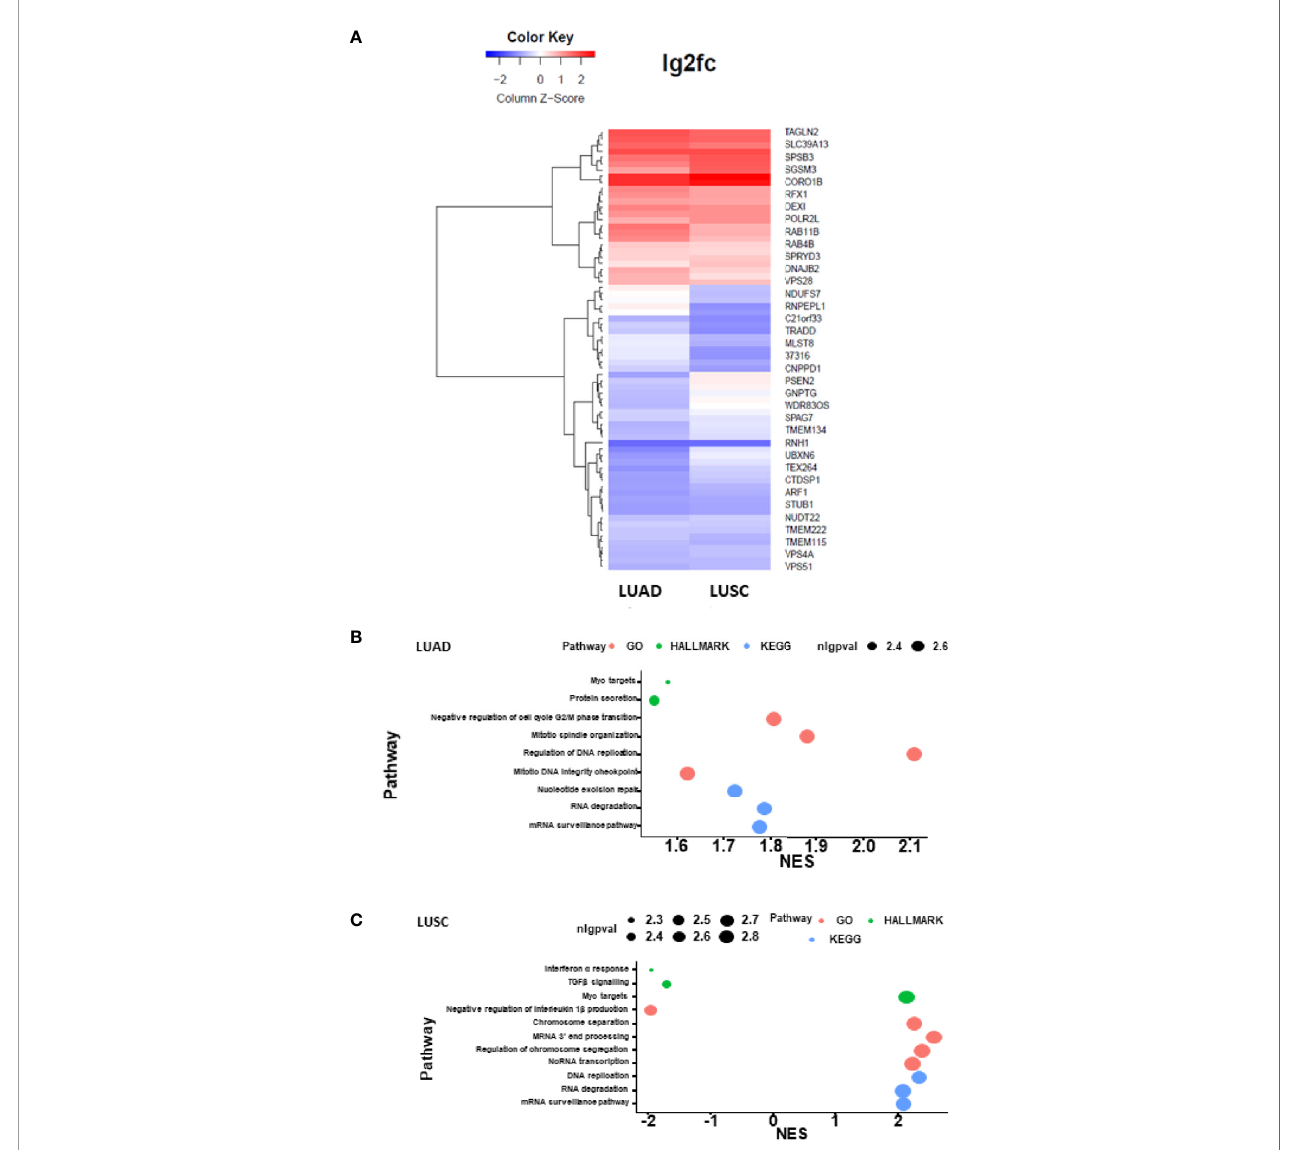
FIGURE 7 | Heatmap plotting and causal pathway analysis of the differential transcript pro fi les affected by DHX36 in LUAD and LUSC. The bioinformatic analysis was conducted using the Pathview Bioconductor package in R. The lung cancer RNA-Seq datasets were obtained from TCGA. (A) Heatmap visualisation of the differential transcripts affected by DHX36. (B) Causal gene set enrichment analysis in LUAD. (C) Causal gene set enrichment analysis in LUSC. The enrichment scores were obtained using multiplex pathway databases including Gene ontology terms (GO), Kyoto Encyclopedia of Genes and Genomes (KEGG) and the Molecular Signatures Database (MSigDB) HALLMARK sets. nlgpval is the abbreviation of the negative log of p